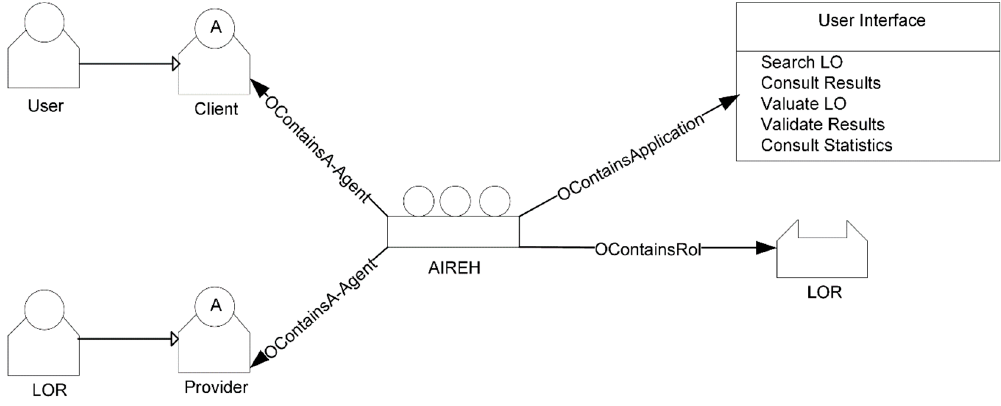
Figure 4. Organizational architecture model diagram (structural view).